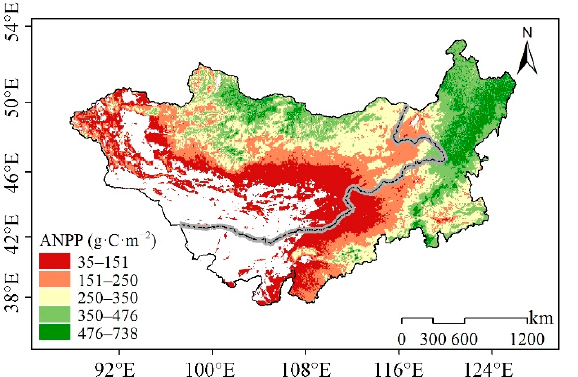
Figure 4. Spatial distribution of the multi-year average ANPP in the Mongolian Plateau from 2000 to 2019.